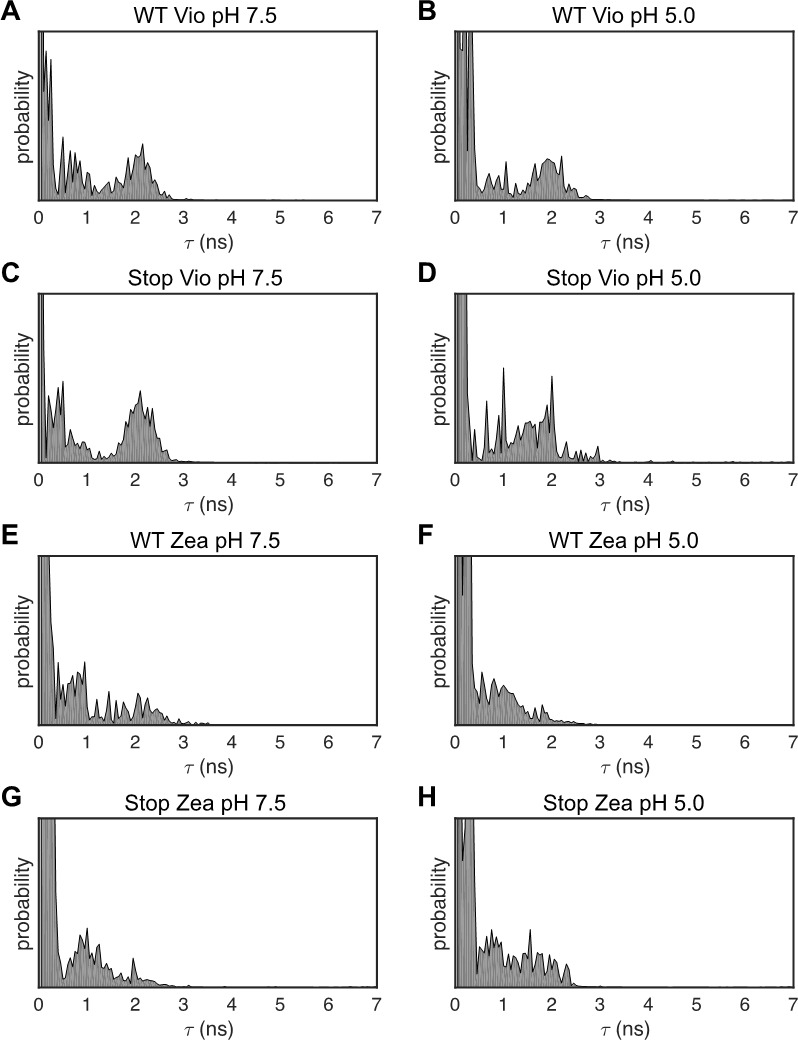
1D Lifetime distributions.Lifetime distributions from the single-molecule fluorescence from all LHCSR3 samples determined using a one-dimensional inverse Laplace transform (1D-ILT) of the 1D fluorescence lifetime decay. Lifetime states identified from the 1D distribution were used as initial parameters in the fit to the 2D distributions in the 2D-FLC analysis.